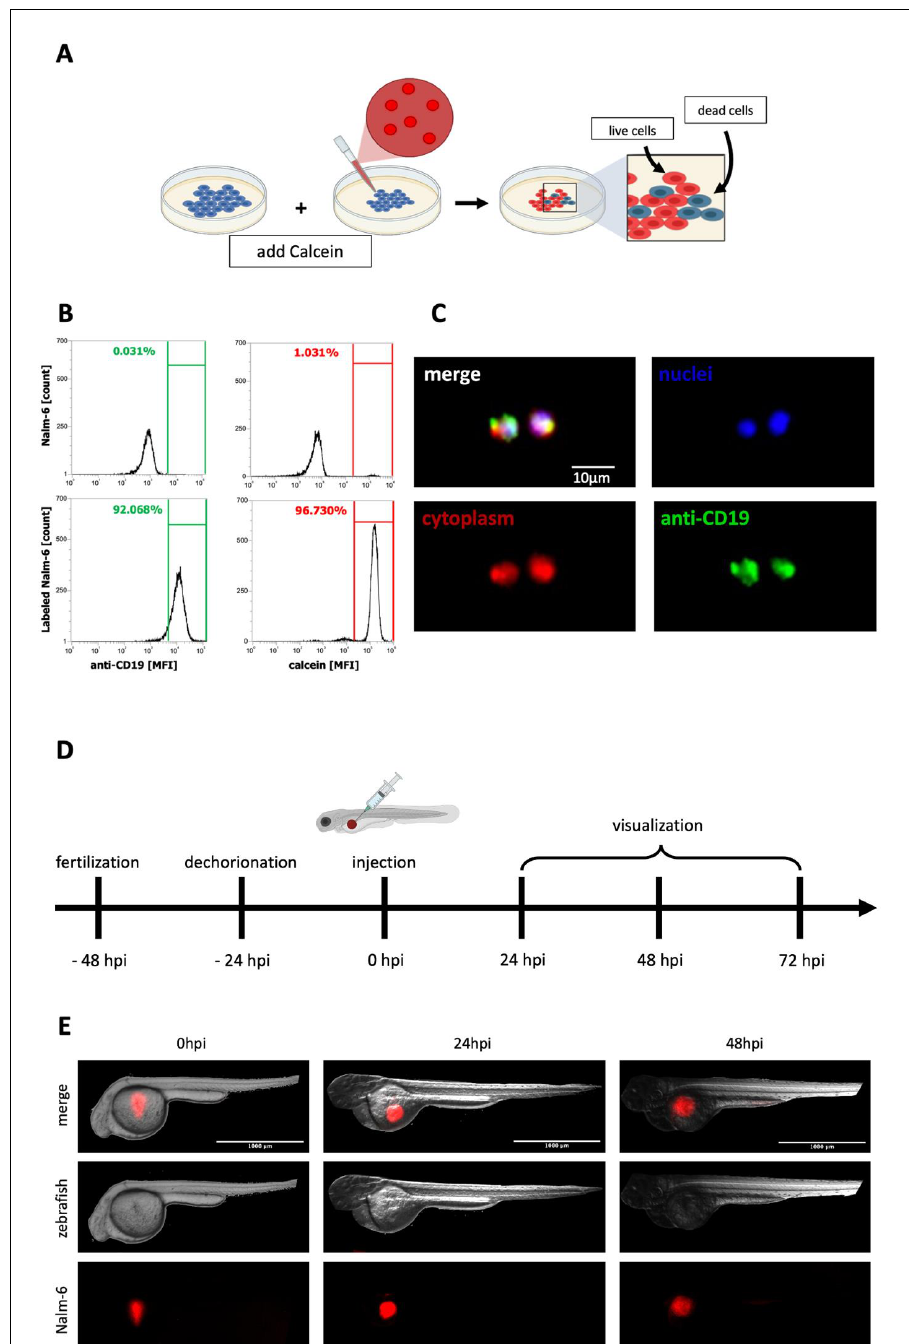
Figure 4. Localized xenograft zebrafish model: ( A ) Nalm-6 cells were labeled with Calcein-AM. After the internalization of Calcein-AM, the non-fluorescent Calcein-AM is converted in living cells to red-fluorescent Calcein-AM. Nalm-6 cells were also labeled with DAPI and anti-CD19 antibody (as described in materials and methods) and analyzed by ( B ) flow cytometric analysis and ( C ) im- munofluorescence microscopy. Magnification 200 × . Scale bar 10 µ m. ( D ) Timeline of the experimental procedure. ( E ) Calcein-AM-labeled Nalm-6 cells were injected at 48 hpf in the perivitelline space of larvae. ZF were analyzed immediately after the injection (left panels), 24 hpi (central panels), and 48 hpi (right panels). Magnification 40 × . Scale bar 1000 µ